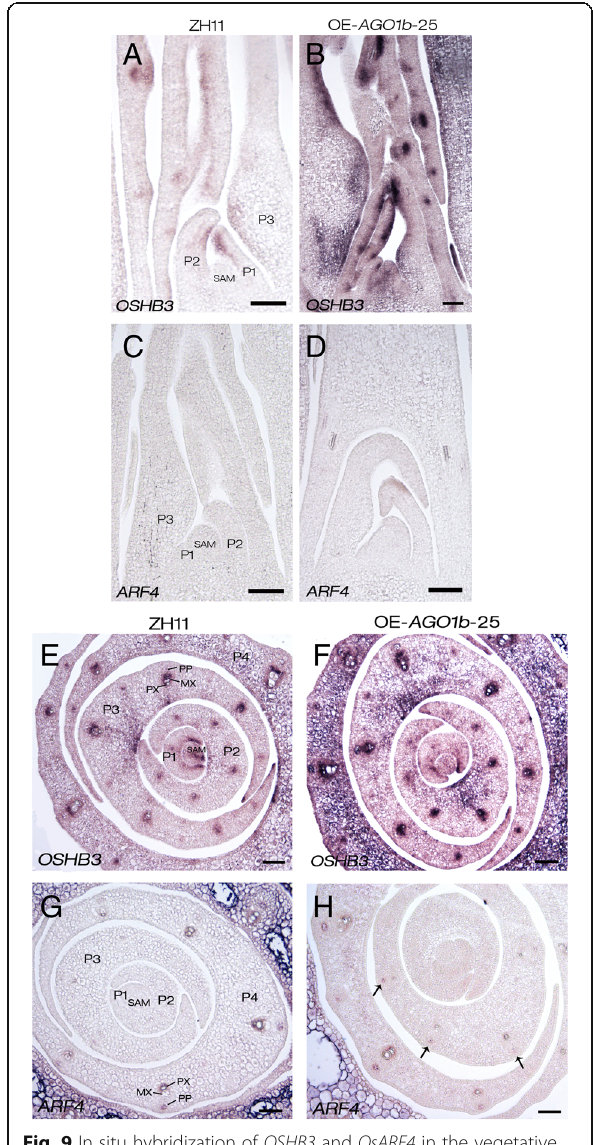
Fig. 9 In situ hybridization of OSHB3 and OsARF4 in the vegetative shoot apex of ZH11 and OE- AGO1b -25. a and b , e and f In situ hybridization of OSHB3 in ZH11 and OE- AGO1b -25. c and d , g and h In situ hybridization of ARF4 in ZH11 and OE- AGO1b -25. a - d Longitudinal sections of 14-day-old seedlings. e - h Cross sections of 14-day-old seedlings. Black arrows in ( h ) showed vascular bundles in P3 primordium of OE- AGO1b lines. Shoot base cuttings about 1 cm in length including SAM of 14-day-old seedlings were used. SAM, shoot apical meristem; P1, P1 leaf primordium; P2, P2 leaf primordium; P3, P3 leafprimordium; P4, P4 leaf primordium; MX, metaxylem; PP, protophloem; PX, protoxylem. Scale bars = 50 μ